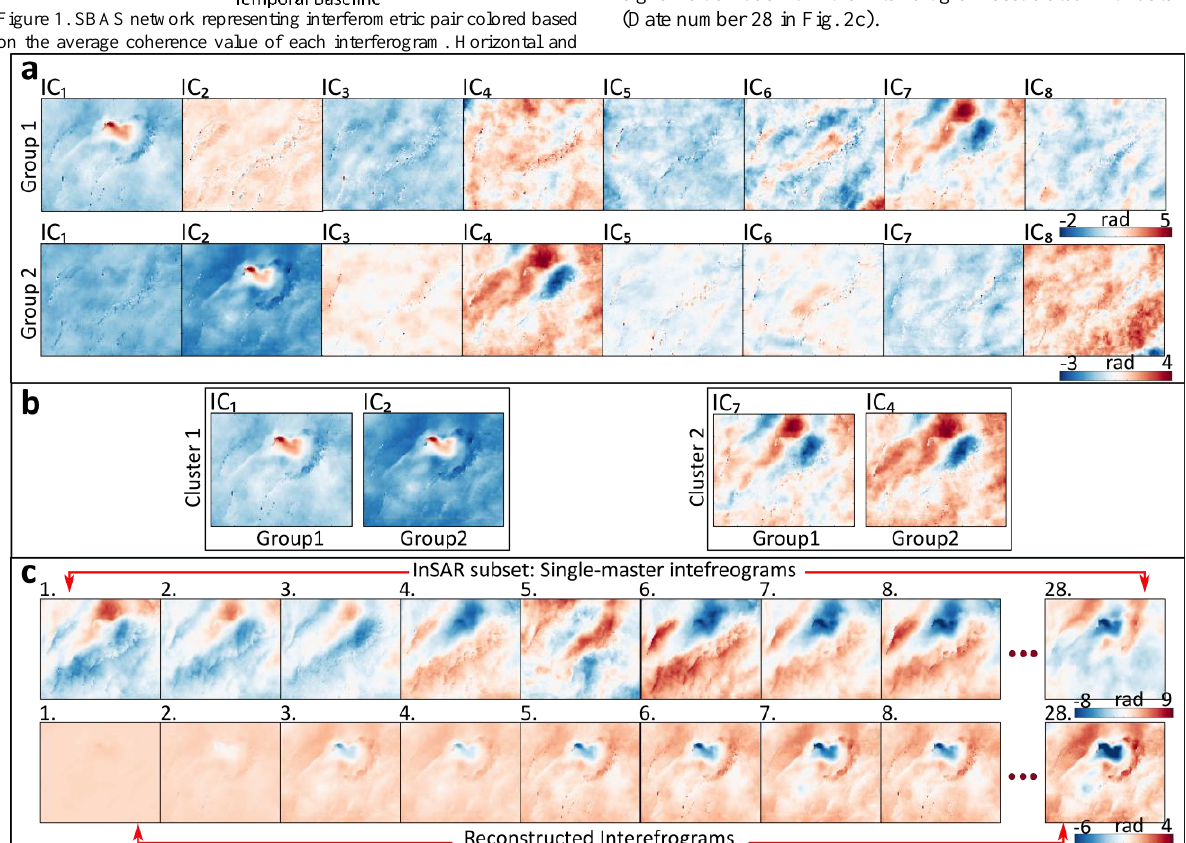
independent sources retrieved from each group. Fig. 2c represents the original interferograms, including 28 interferometric pairs versus the reconstructed interferograms. A dominant pattern is related to the turbulent mixing noise of the master image, which covers all the original interferograms, the pattern hides the postseismic signal. But when postseismic deformation is accumulated over time, the geophysical signal gets large enough to overcome atmospheric noise. For instance, despite the large atmospheric error, a distinguishable postseismic signal is obvious from the interferogram associated with date 28 (Date number 28 in Fig.